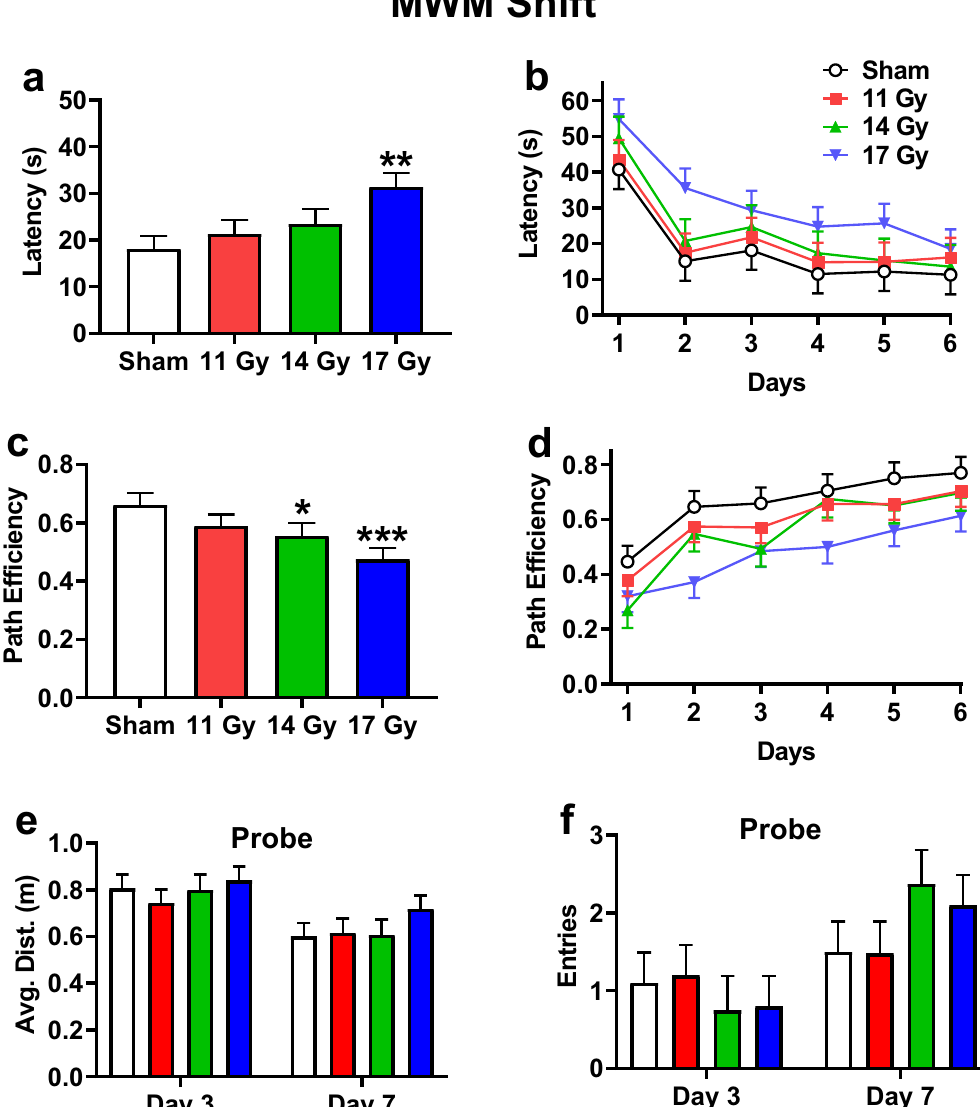
Figure 9. Shift phase Morris water maze performance in proton irradiated and control rats. ( a ) Overall effect on latency to the platform. ( b ) Learning curve for latency with all groups. ( c ) Overall effect on path efficiency. ( d ) Learning curve for path efficiency. ( e ) Average distance from the former platform site on day-3 and -7 probe trials. ( f ) Number of entries into the former platform site on day-3 and day-7 probe trials. There was an interaction for entries with the 11 Gy rats having fewer entries than the controls. * p < 0.05, ** p < 0.01, *** p < 0.001 compared with controls. N = 10/control, 11 Gy, and 17 Gy and n = 8 for the 14